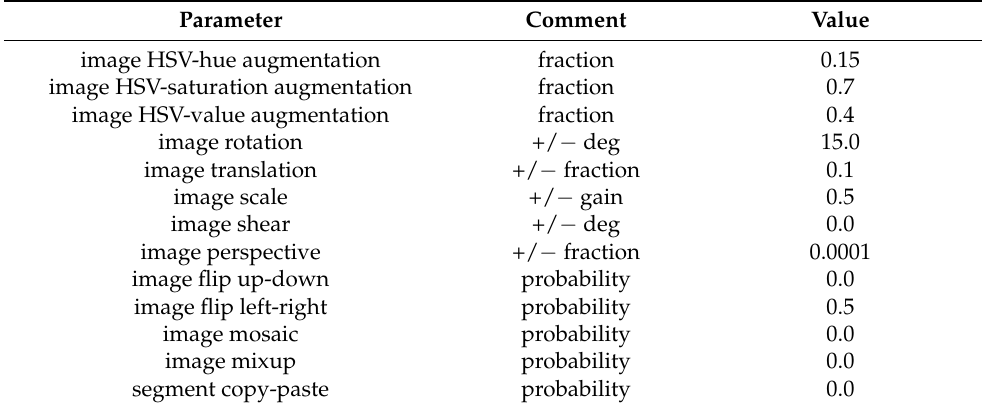
Table 1. Hyperparameters used for neural network